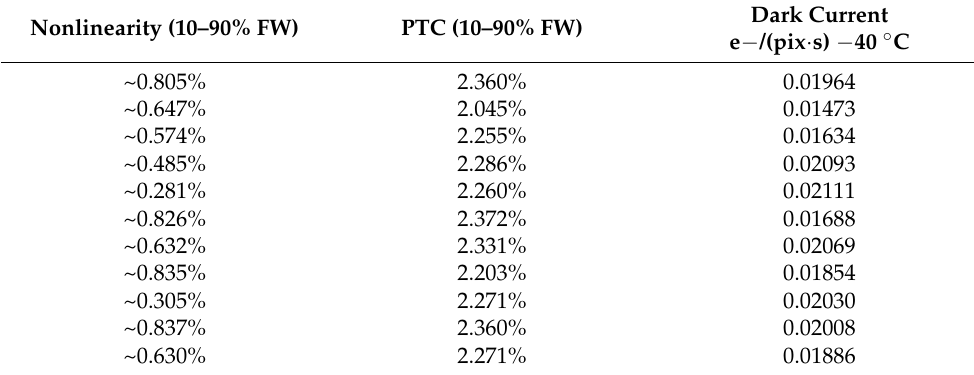
Table 5. The 10 times Nonlinearity, PTC and Dark current test results. Nonlinearity (10–90% FW)